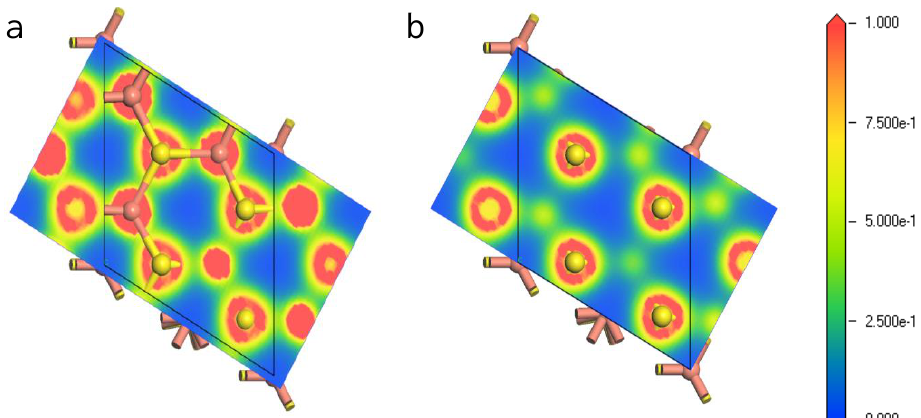
Figure 5. Electron density of bornite (111)-S surface before and after reconstruction in DFT calculation (CASTEP module of Materials Studio 6.0 software package, PBE density function, Hubbard + U correction): ( a ) The first layer of optimized (111)-S surface; ( b ) The first layer of initial (111)-S surface.